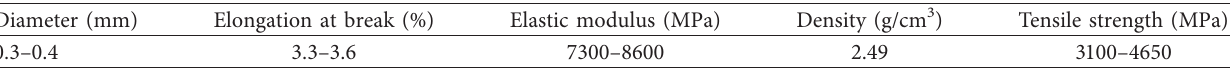
Table 2: The basic parameters of glass